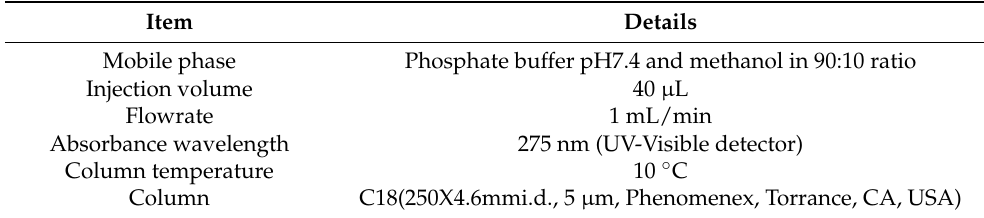
Table 1. HPLC Conditions for determination of Gem recovery from